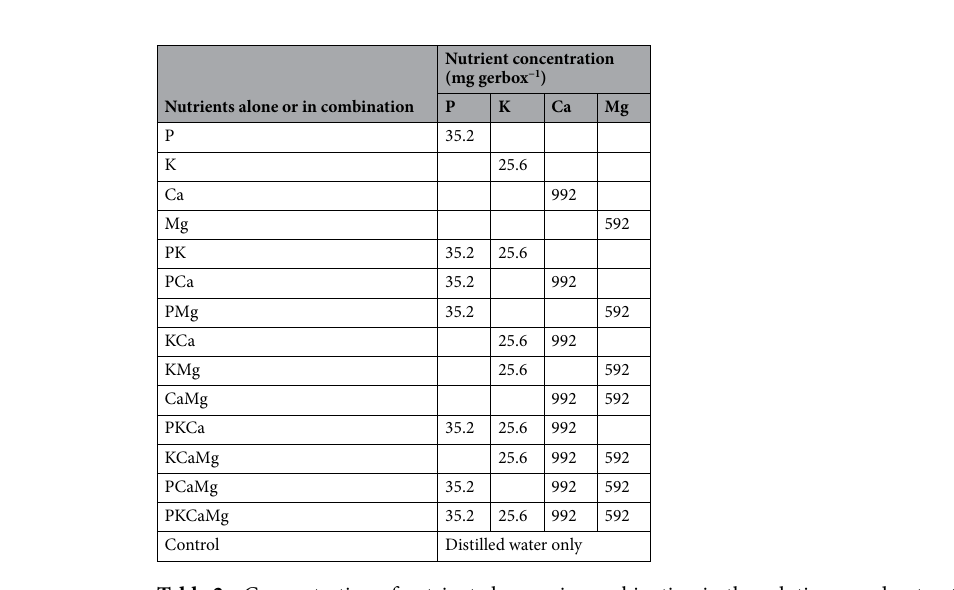
Table 2. Concentration of nutrient alone or in combination in the solutions used as treatment. Nutrient source: